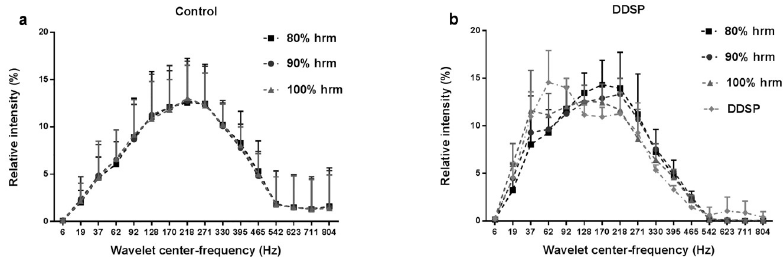
Fig 8. Relative contribution (% of the total intensity) of the 16 wavelets to the thyro-hyoid muscles electromyographic activity during each exercise intensity interval. 8a) Normal horses (control) showed a uniform contribution of each wavelet throughout the exercise. 8b) Horses affected by palatal instability and intermittent dorsal displacement of the soft palate (DDSP), showed a progressive decrease in the contribution of the high frequency wavelets with shift toward a higher low frequency wavelets contribution at highest exercise intensity (100% HRM), and minimum of high frequencies contribution in two horses in the interval preceding the displacement of the soft palate (DDSP). Data expressed as mean ±